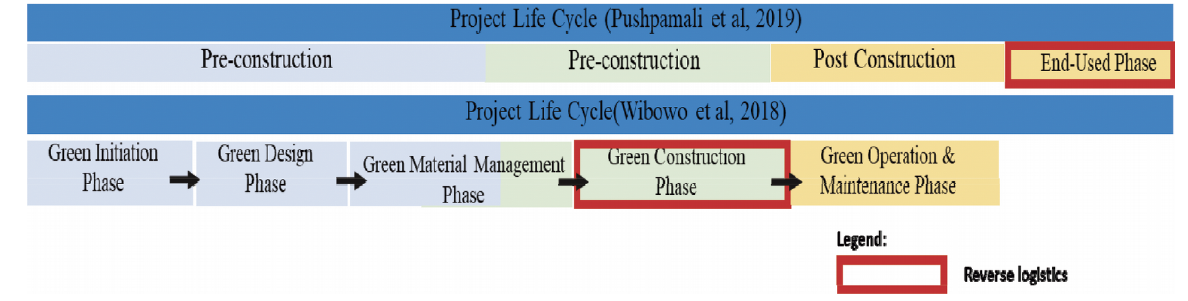
Figure 1. The difference between Life Cycle Concept In Green